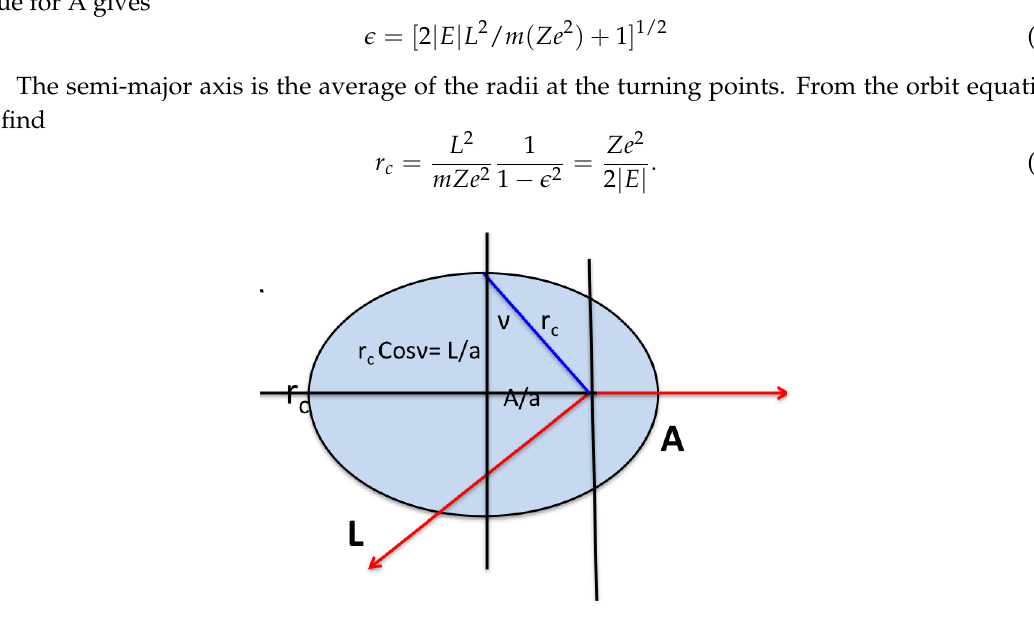
Figure 1. The classical limit of the orbital is a non-precessing ellipse with constant L and A . The semi-major axis is r c and L 2 + A 2 = a 2 r 2 = (cid:105) energy. The eccentricity (cid:101) = sin ν and a = ( − 2 mE ) 1/2